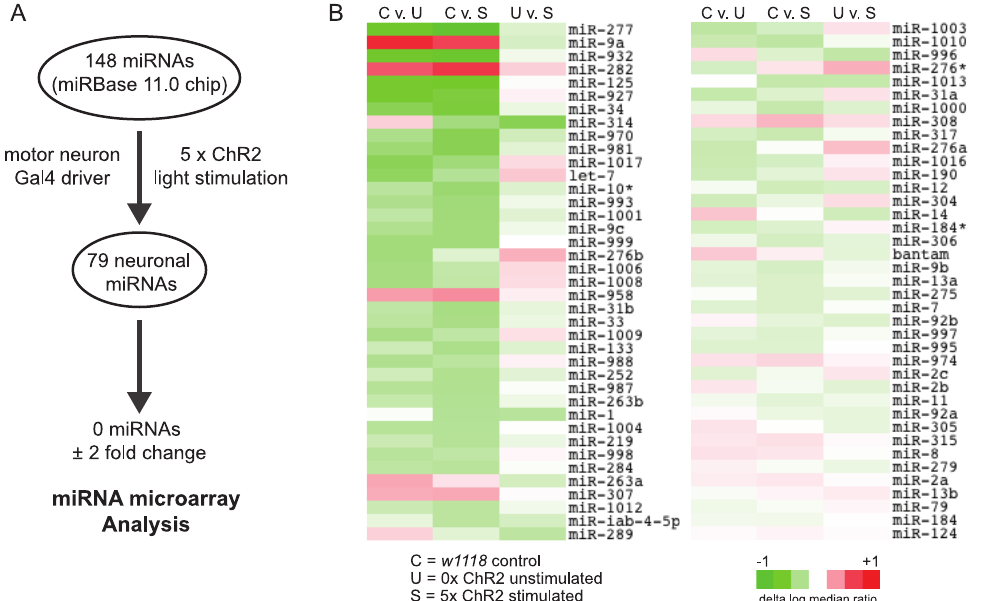
Figure 2. miRNA expression profile of the Drosophila larval CNS. (A) Flowchart showing miRNA microarray analysis. The expression of 79 mature miRNAs was detected in the Drosophila larval CNS. (B) Heat map showing fold-change of miRNAs in the CNS of w 1118 (control or ‘‘C’’), ChR2 mock stimulated (unstimulated or ‘‘U’’), and ChR2 light stimulated (stimulated or ‘‘S’’) larvae. No neuronal miRNA exhibited a greater than 2-fold change in expression levels following ChR2 light stimulation. The largest differences observed were between the w 1118 and C380-Gal4 x UAS-ChR2 genotypes.